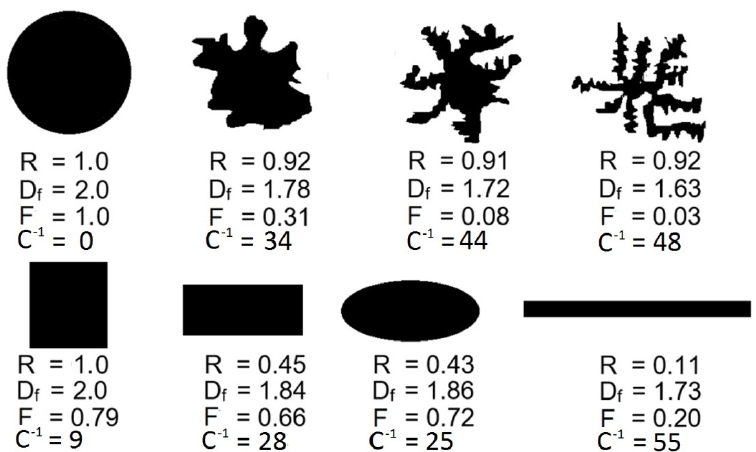
Figure 7. Effect of different shapes on roundness, fractal dimension and shape factor. C -1 is also included, indicating how far a shape is from a perfect circle (in